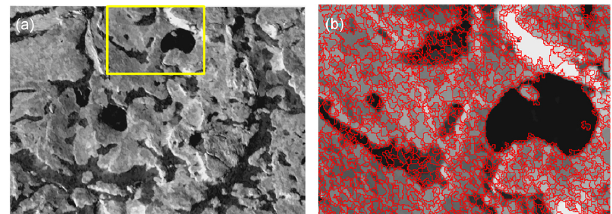
Figure 15. Initial steps on the object-oriented classification scheme: (a) filtered image by suppression of its extremes values with a con- trast criterion (mathematical morphology h-max and h-min opera- tors), (b) detail of the segmentation by watershed with the delin- eation of the objects of the filtered